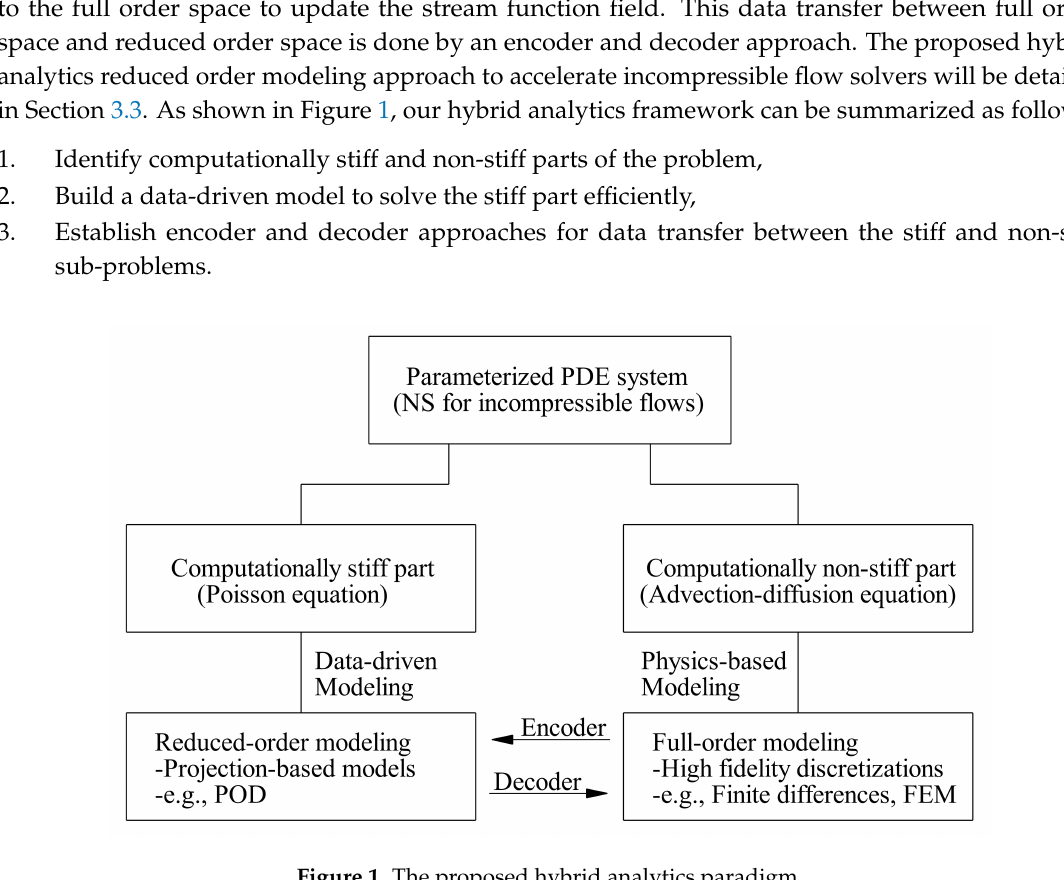
Figure 1. The proposed hybrid analytics